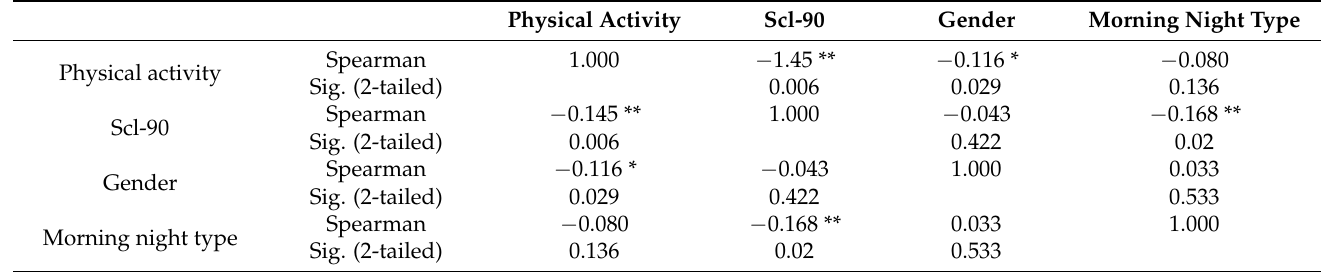
Table 2. Correlation between gender, physical activity, circadian rhythm differences, and scl-90in people with psychological disorders N =